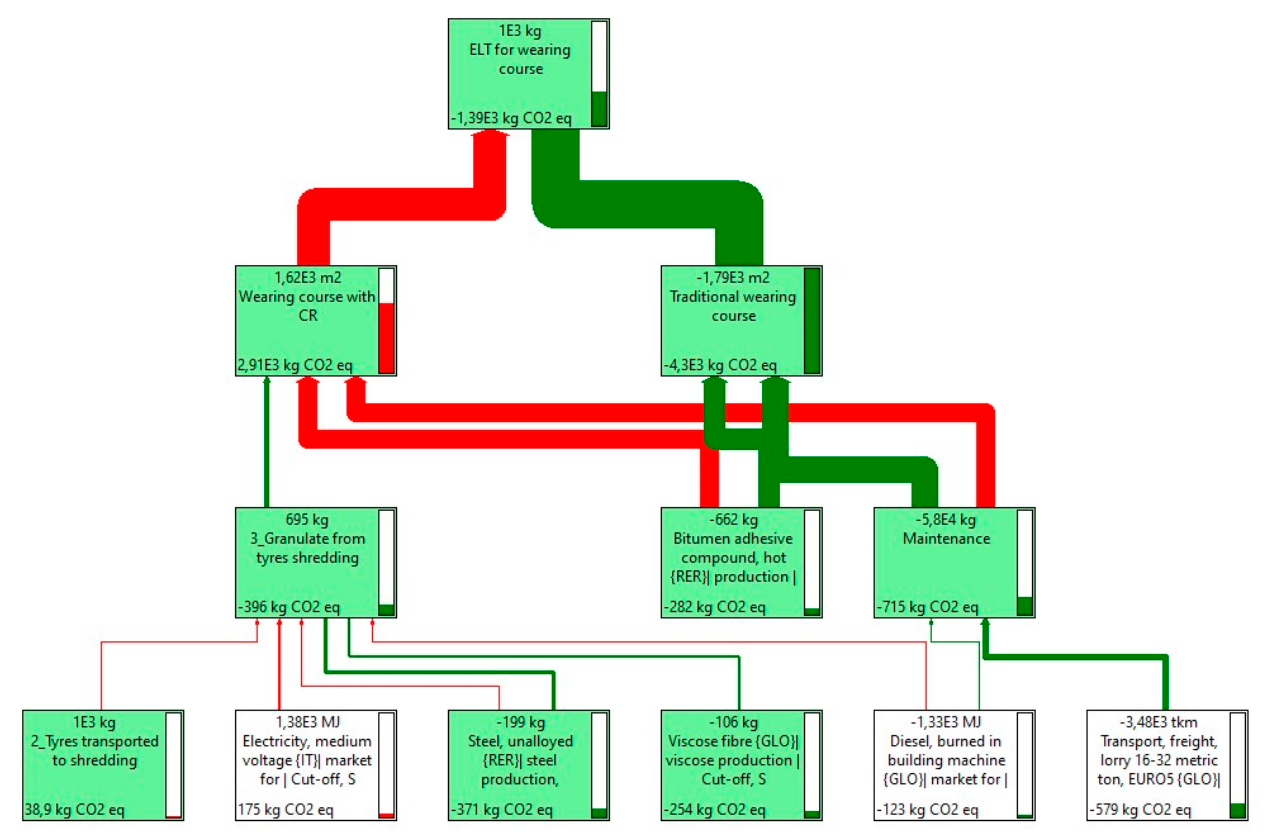
Figure 5. Flow chart with impacts and benefits of the recycling scenario.